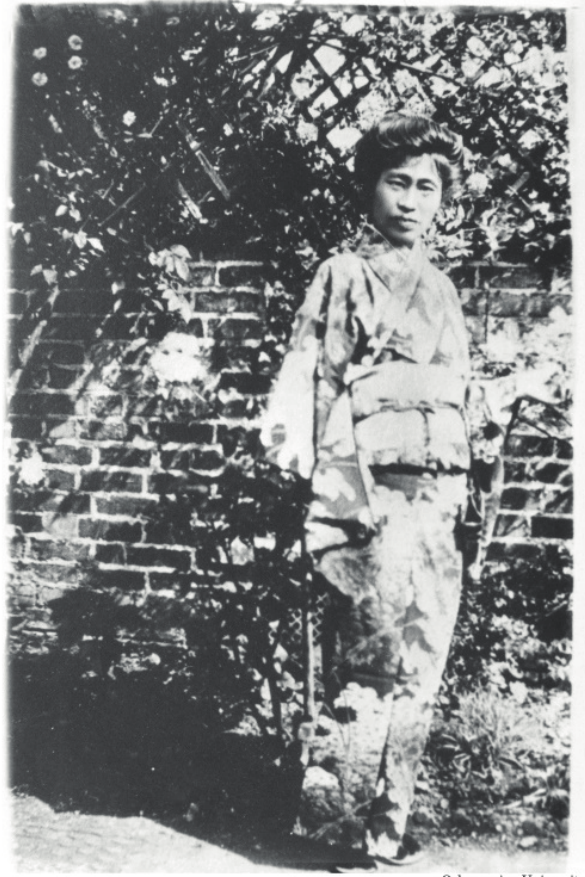
Figure 3. (Ku-6016) Kuroda Chika in Oxford, Taisho11, 1922.